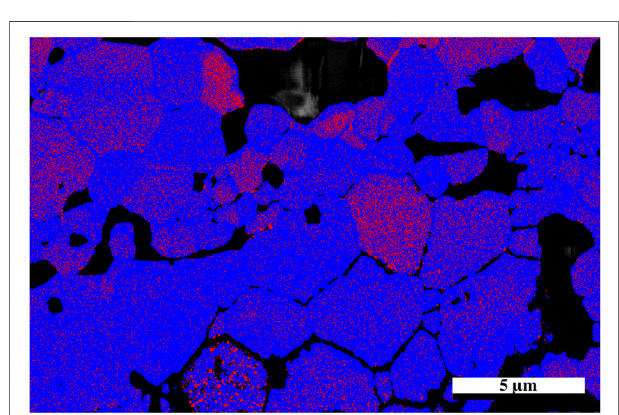
FIGURE 6 | High resolution EBSD phase map of irradiated Nd 2 Zr 2 O 7 utilizing cifs generated from neutron diffraction assigned to the undamaged and damaged parts of the sample, direction of He 2+ ions are from the bottom of the image. Red areas indicate phase 1.